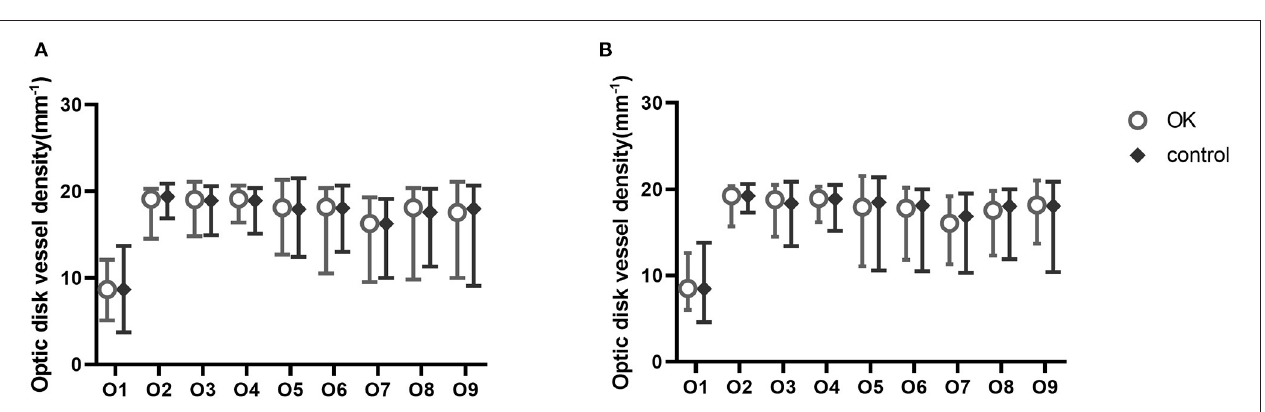
FIGURE 5 | Nine zones of optic disc vessel density at baseline (A) and at 6 months (B) .